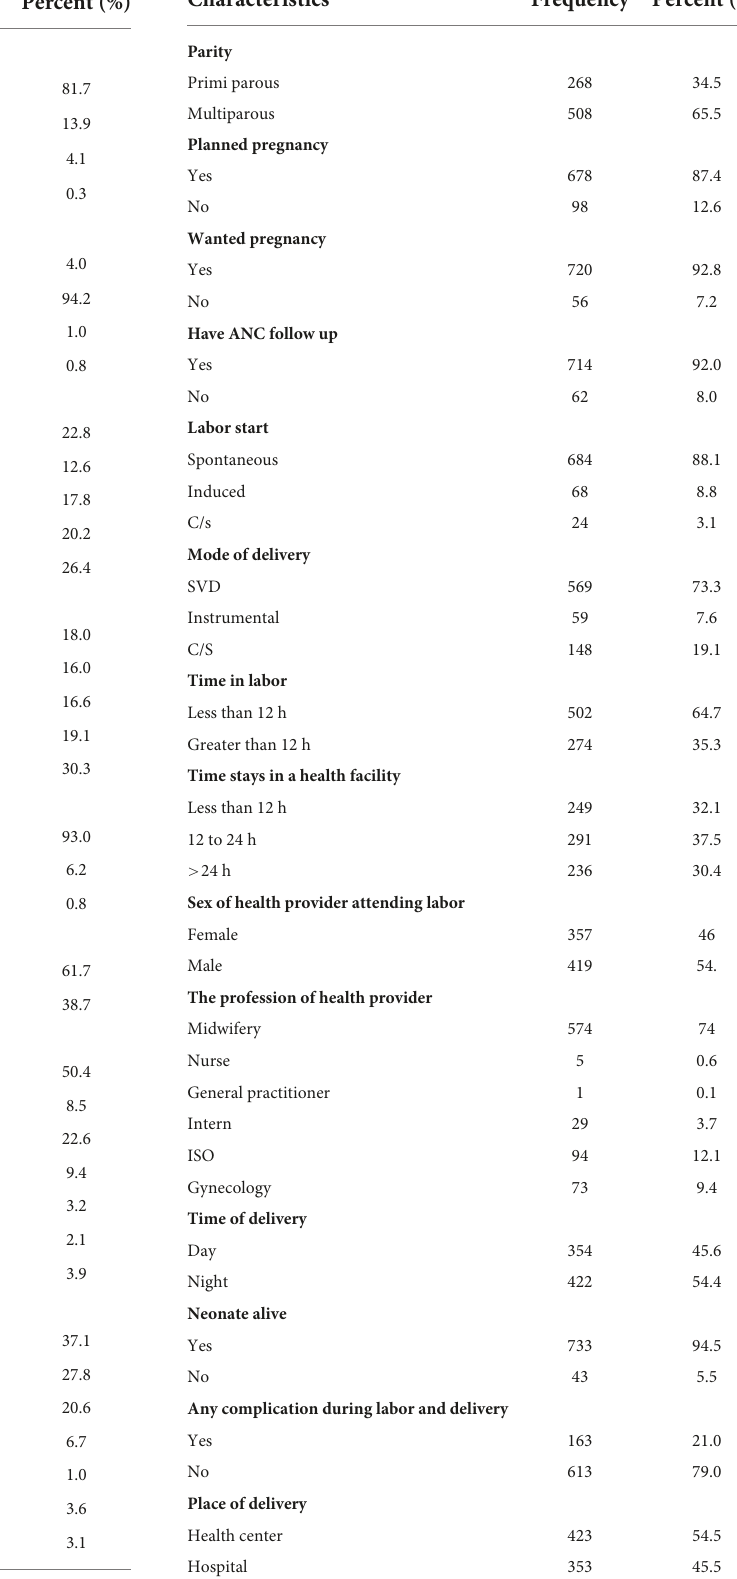
TABLE 1 Sociodemographic characteristics. TABLE 2 The obstetric/Health care service-related